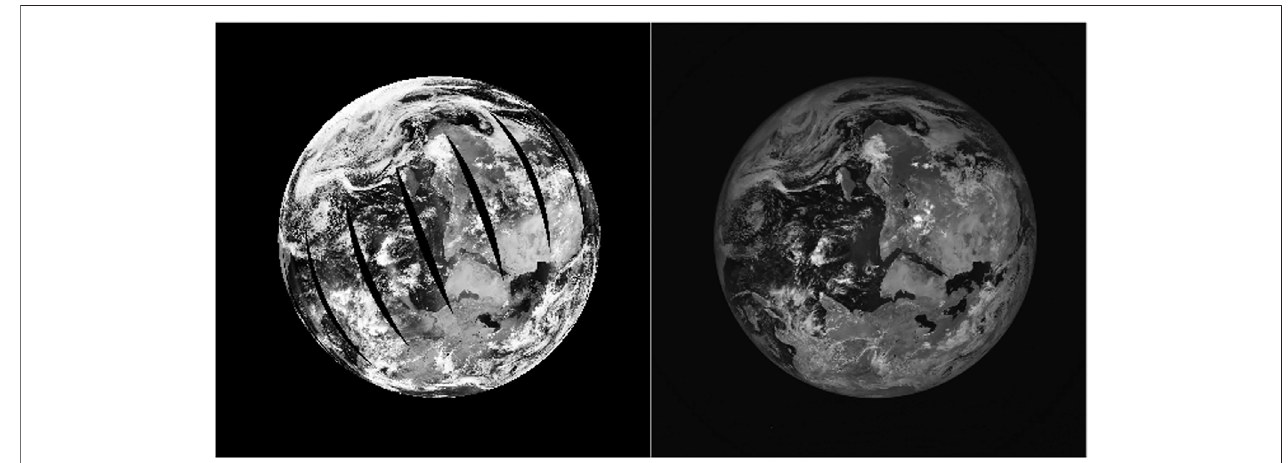
FIGURE 9 | Left: MODIS data simulated as EPIC portraying the fi nal solution of the algorithm. Right: Actual EPIC image the algorithm was performed against.